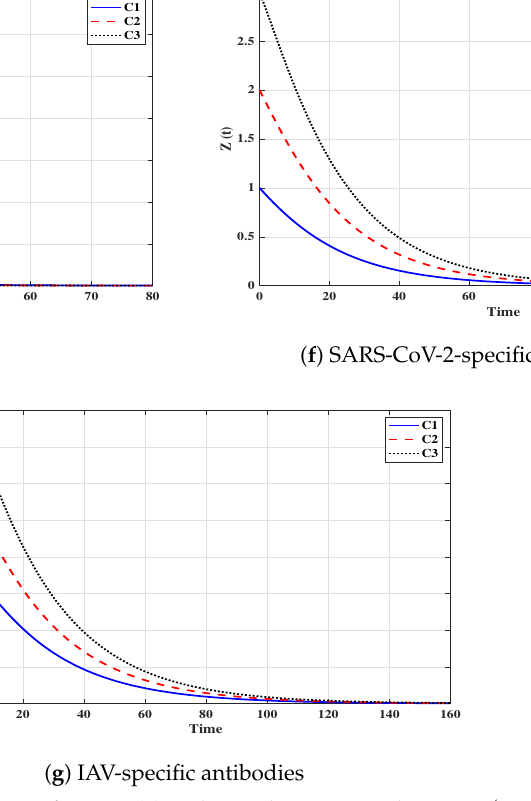
Figure 2. Solutions of system (3) with initials C1–C3 tend to Ξ 0 = ( 10,0,0,0,0,0,0 ) when (cid:60) 1 ≤ 1 and (cid:60) ≤ 1 (Situation 1). 2